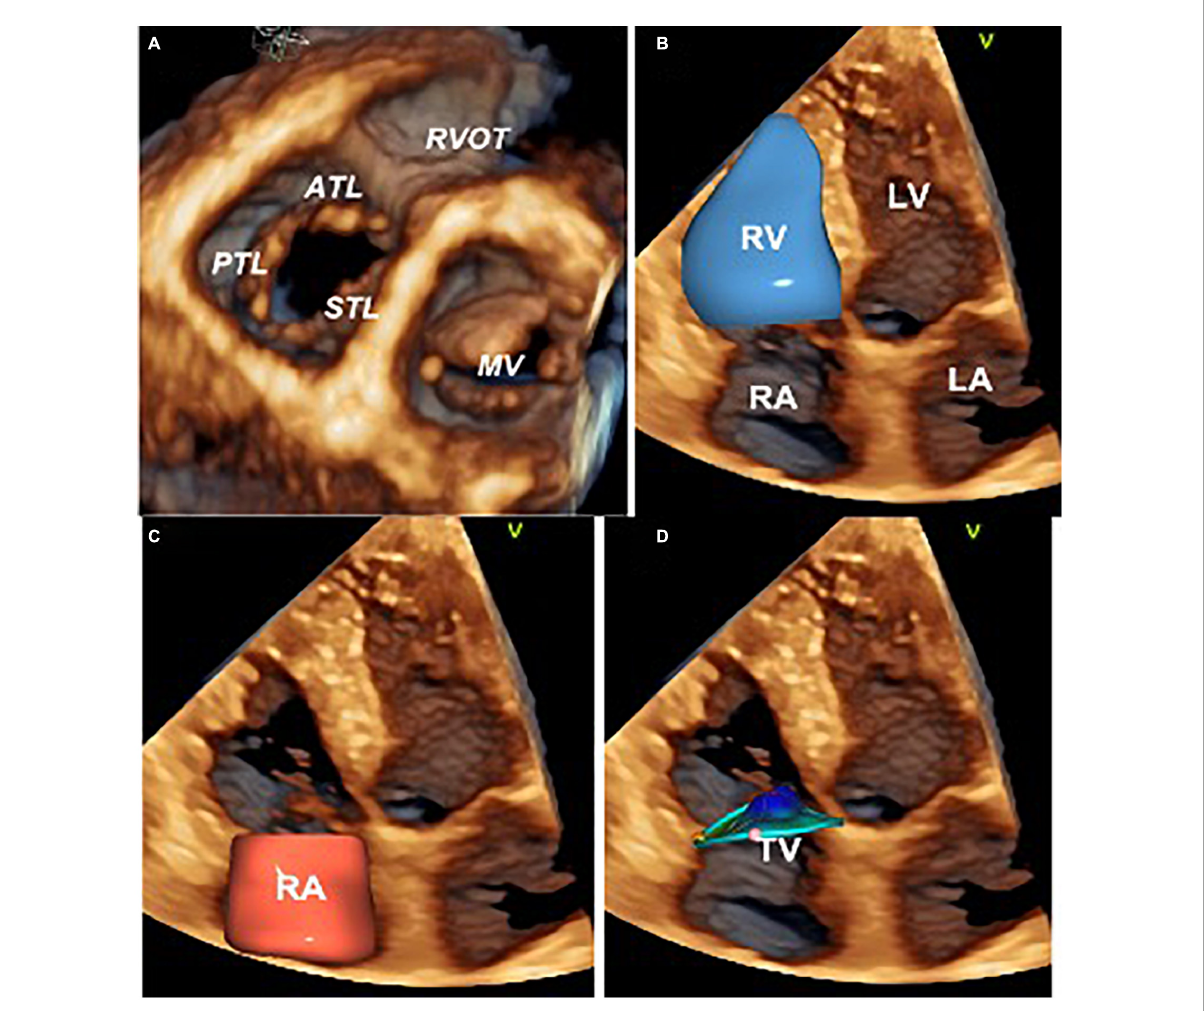
FIGURE1 Three-dimensional echocardiography assessment of the tricuspid valve, right heart chambers, and tricuspid annulus. Ventricular view of the tricuspid and mitral valve leaflets by transthoracic three-dimensional echocardiography (A) . Surface rendering and volumetric analysis of the right ventricle (B) and right atrium (C) . Surface rendering and measurement of the tricuspid annulus size and shape with 4D AutoTVQ software package (GE Vingmed, Horten, NO) (D) . ATL, anterior tricuspid leaflet; LA, left atrium; LV, left ventricle; MV, mitral valve; RVOT, right ventricle outflow tract; PTL, posterior tricuspid leaflet; RV, right ventricle; RA, right atrium; STL, septal tricuspid leaflet; TV, tricuspid